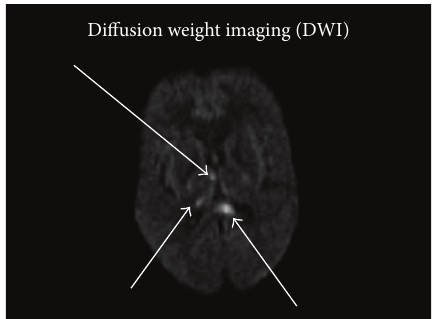
Figure 4: DWI shows bright areas (restricted diffusion) in the spleniumofthecorpuscallosumandrightthalamuscompatiblewith infarcts. These areas were low on the apparent diffusion coefficient maps which confirms that these are infarcts (not shown). Infarcts are a known complication of